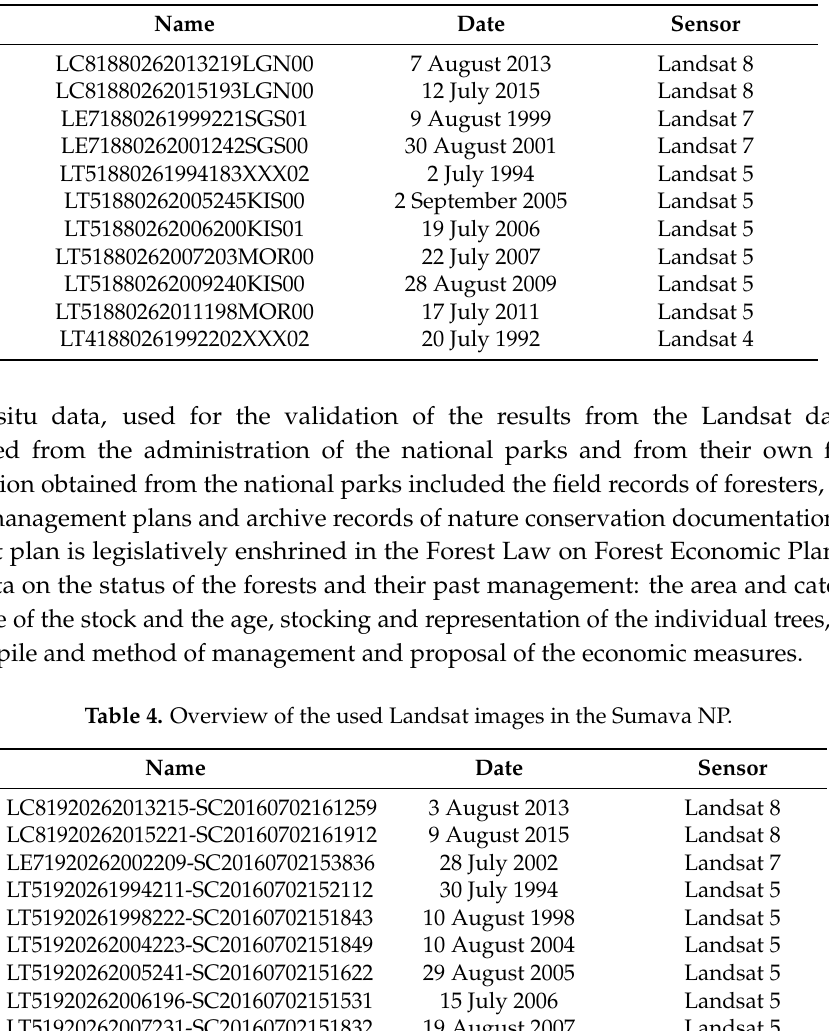
Table 3. Overview of the used Landsat images in the Low Tatras NP.